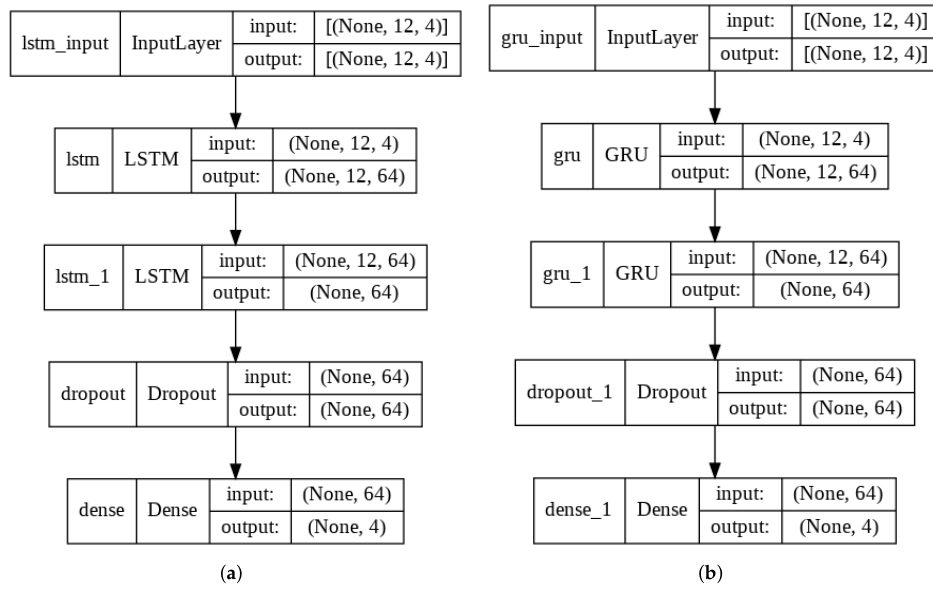
Figure 2. Architecture of the recurrent neural networks. ( a ) LSTM-NN; ( b )